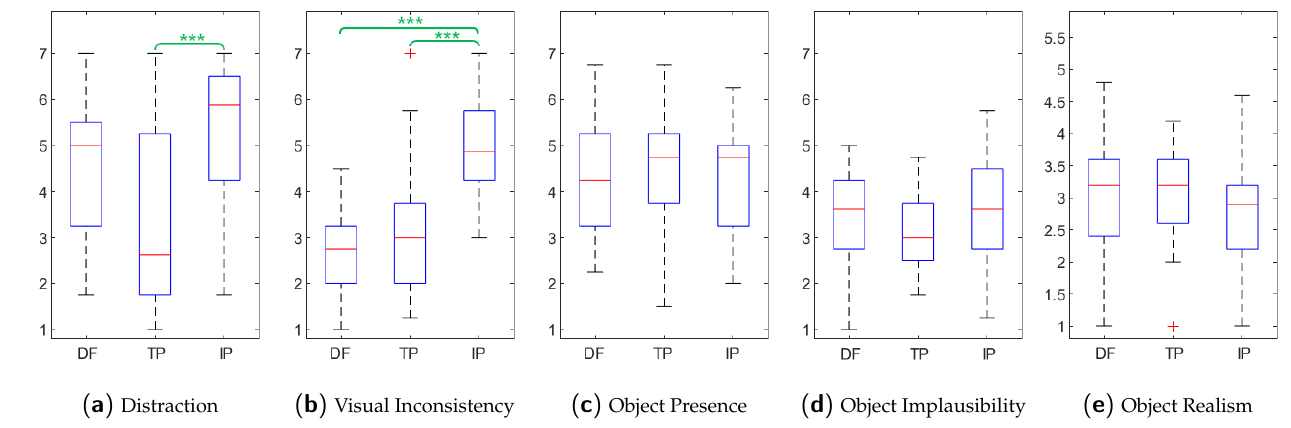
Figure 7. Results of subjective measures in the experiment (*: p <0.05, **: p <0.01, ***: p <0.001). Table 4. Experimental and analysis results (* p < 0.05; ** p < 0.01; *** p <